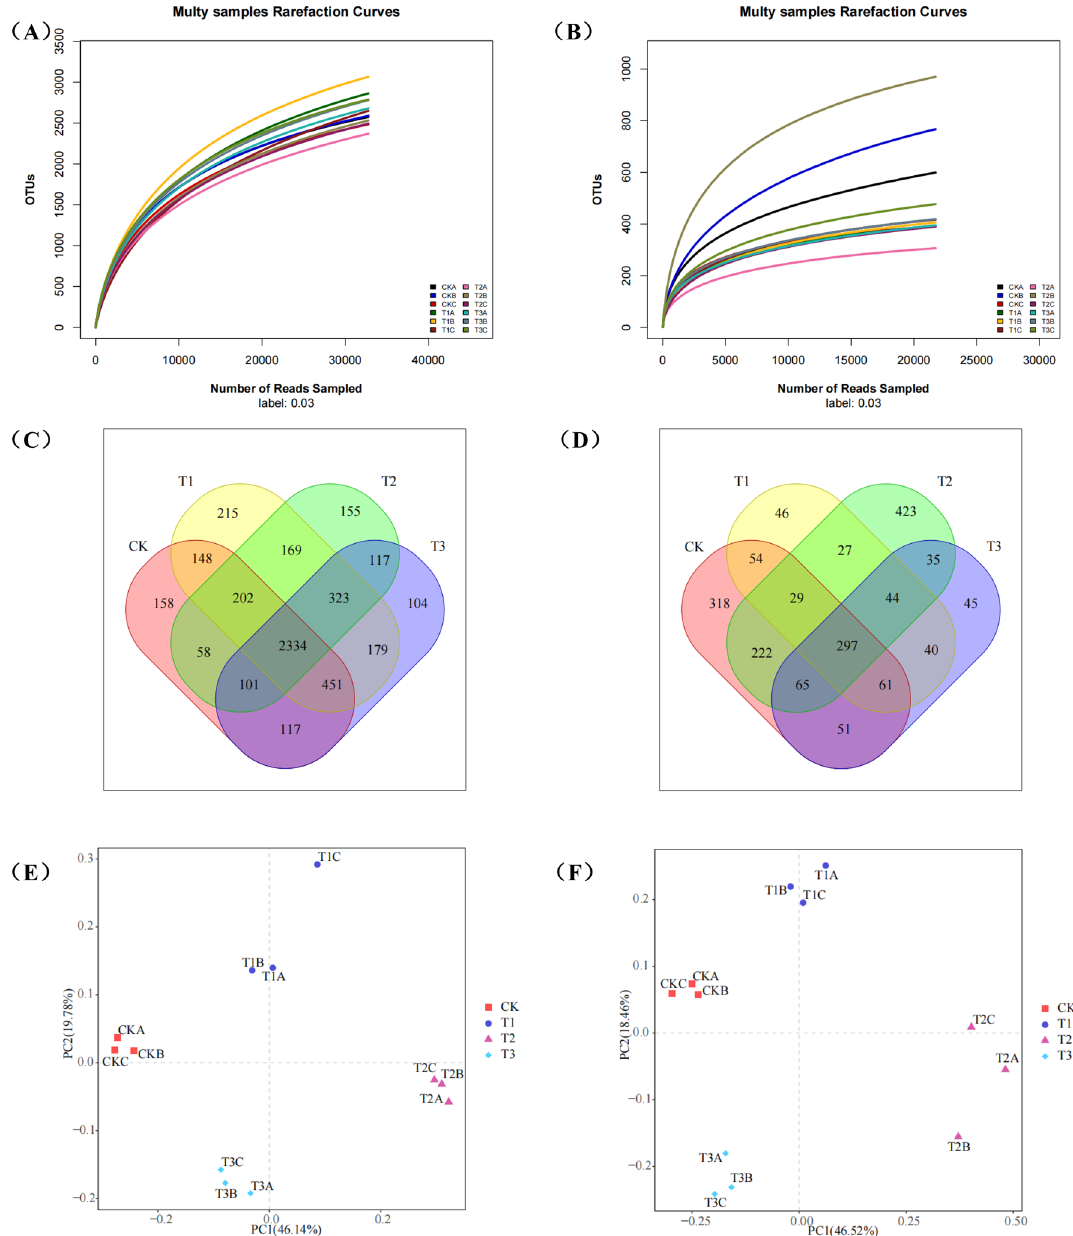
Figure 3. Rarefaction curves for bacteria (A) and fungi (B) . Venn diagrams of microbial communities based on OTU for bacteria (C) and fungi (D) . Bray–Curtis PCoA for bacteria (E) and fungi (F) of different treatments on OTUs level.